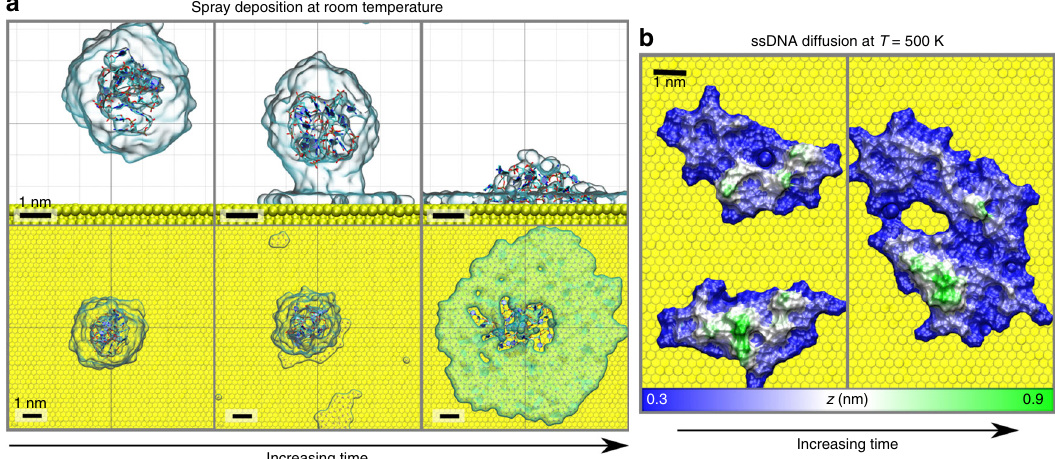
Fig. 2 Molecular dynamics simulations of adsorption and diffusion on Au(111). a Side- and top views of a small water droplet containing one ssDNA oligomer getting adsorbed on the gold surface. Water is represented using a transparent surface. b Five-hundred nanosecond MD simulation of two oligomers assembled by diffusion at 500 K (stage 5 of the simulation protocol — see Supplementary Notes 3 and 6). At 500 K, both oligomers start diffusing, thus favoring self-assembly assisted by intermolecular